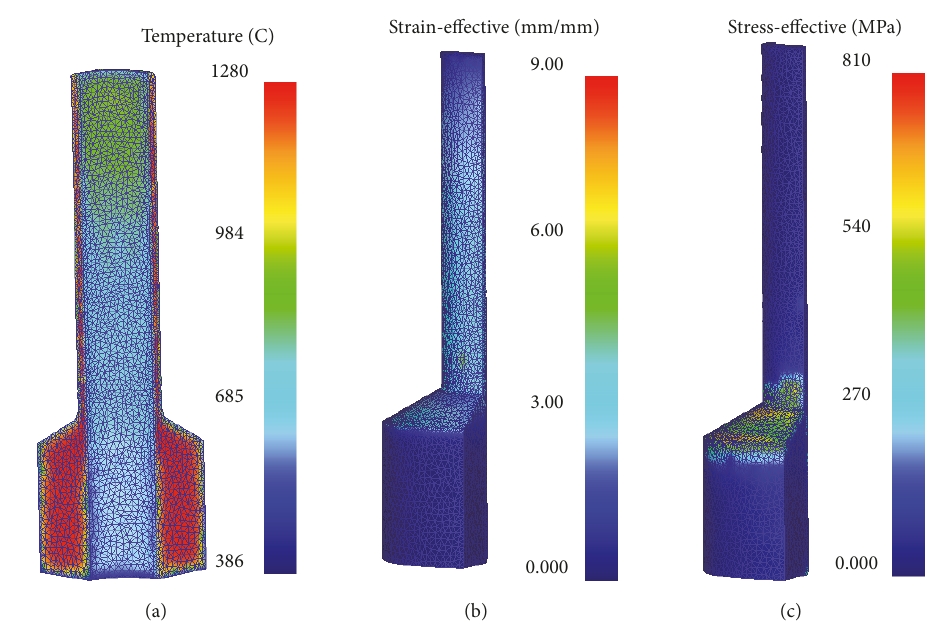
Figure 18: Simulation results of hot extrusion at temperature field (a); effective strain field (b); effective stress field (c).